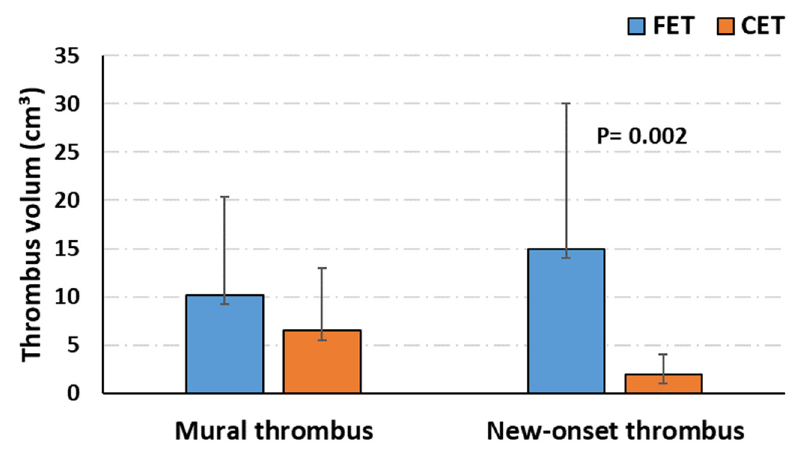
Table 3. Postoperative inflammatory markers in the whole population and divided according to the presence of IR.